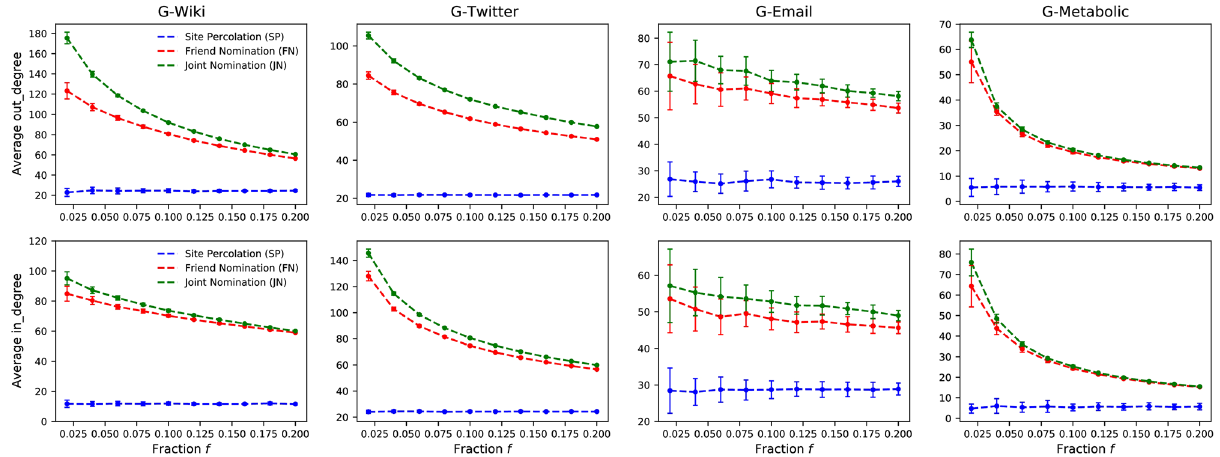
Figure 5. The average in-degree and out-degree of the selected vital nodes using the SP, FN and JN strategies (blue, red and green lines, respectively) on four real-world directed networks. The results are averaged over 50 independent